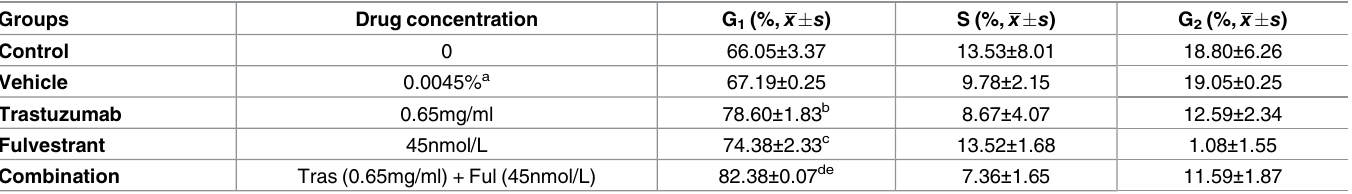
Table 4. Effects on the cell cycle progression of ZR-75-1 cells treated with trastuzumab or fulvestrant or with a combination of both. Groups